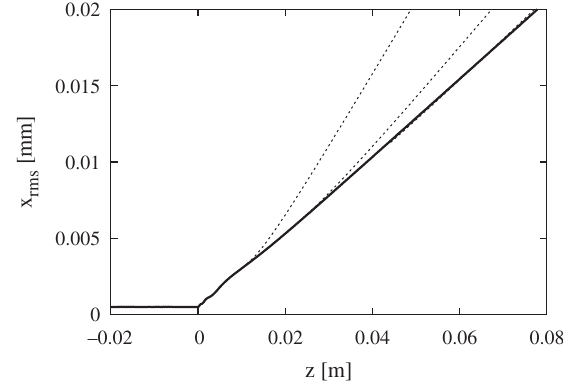
FIG. 3. Development of the normalized phase-space emittance behind a plasma channel. Parameters and line styles correspond to Fig. 2. The trace-space emittance (not shown) stays constant in all cases.